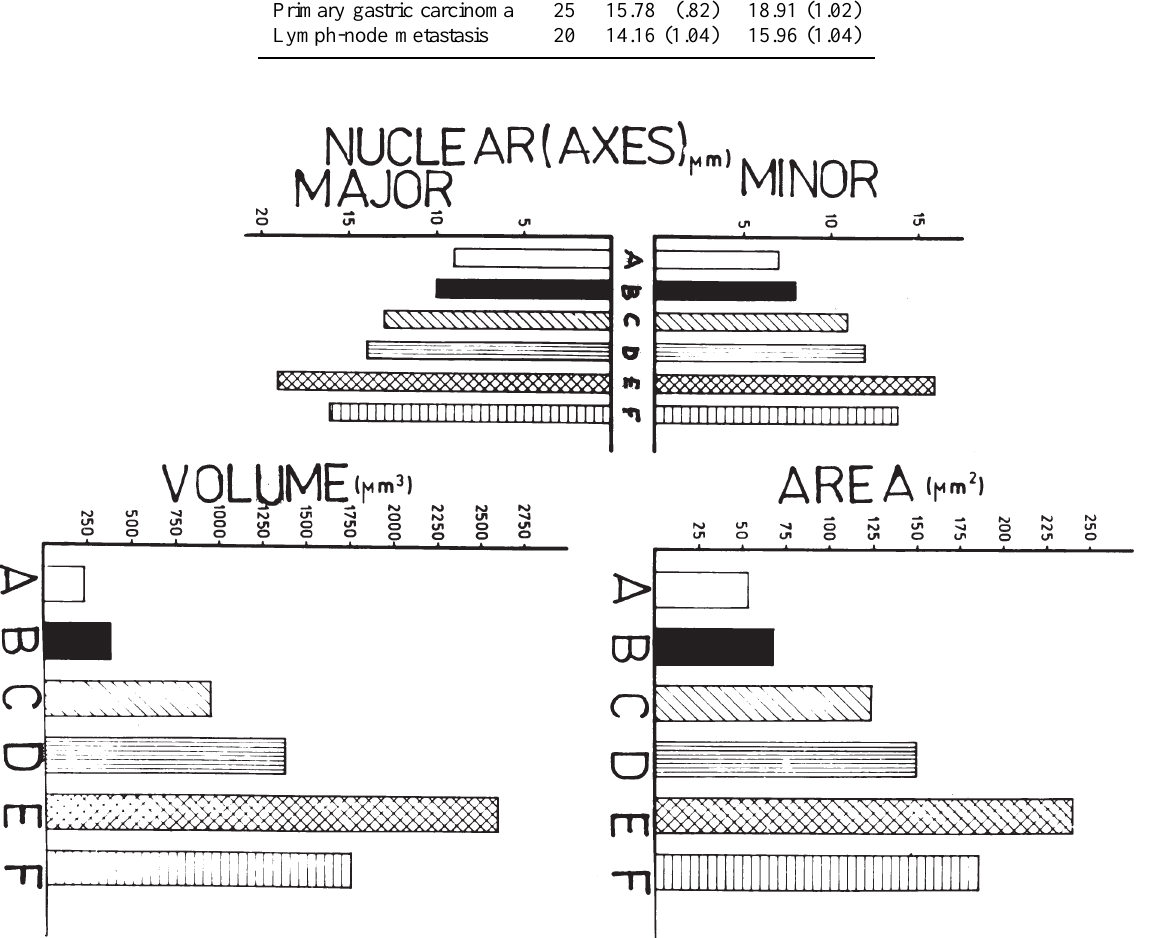
Fig. 2. Histograms of nuclear profile minor (B N ) and major (L N ) elliptic axes, pooled between patients. A: normal gastric mucosa; B: chronic gastritis; C: chronic gastric ulcers; D: adenomatous gastric polyps; E: primary gastric carcinomas; F: lymph-node